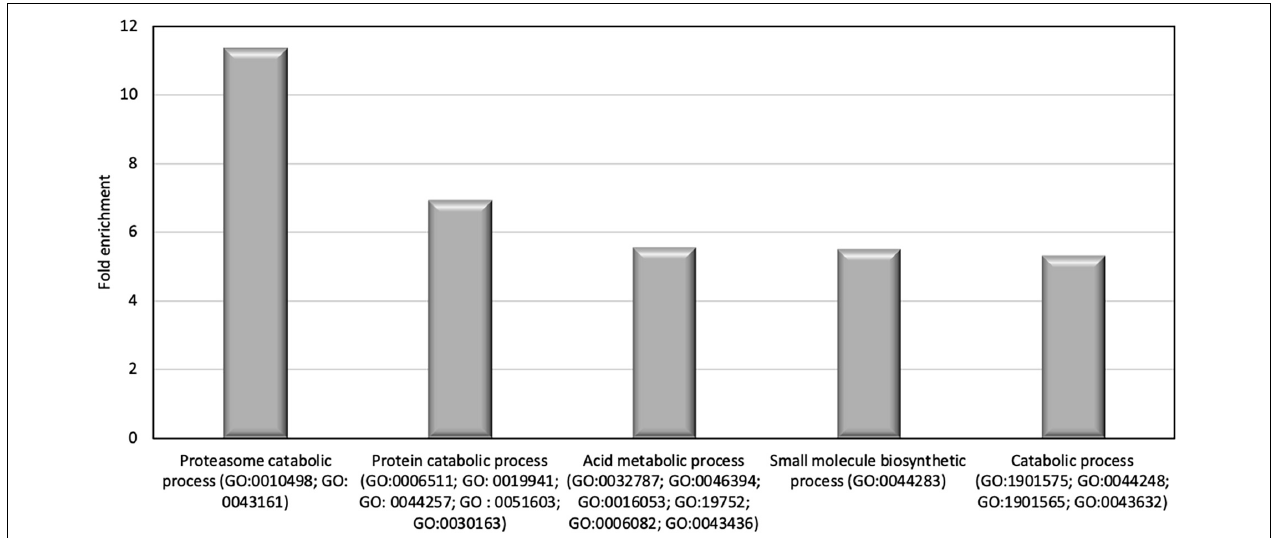
FIGURE 11 | Results of the overrepresentation test (Panther) of the 163 proteins found in the oval cell culture medium. Only proteins families with a fold enrichment upper than 4 are